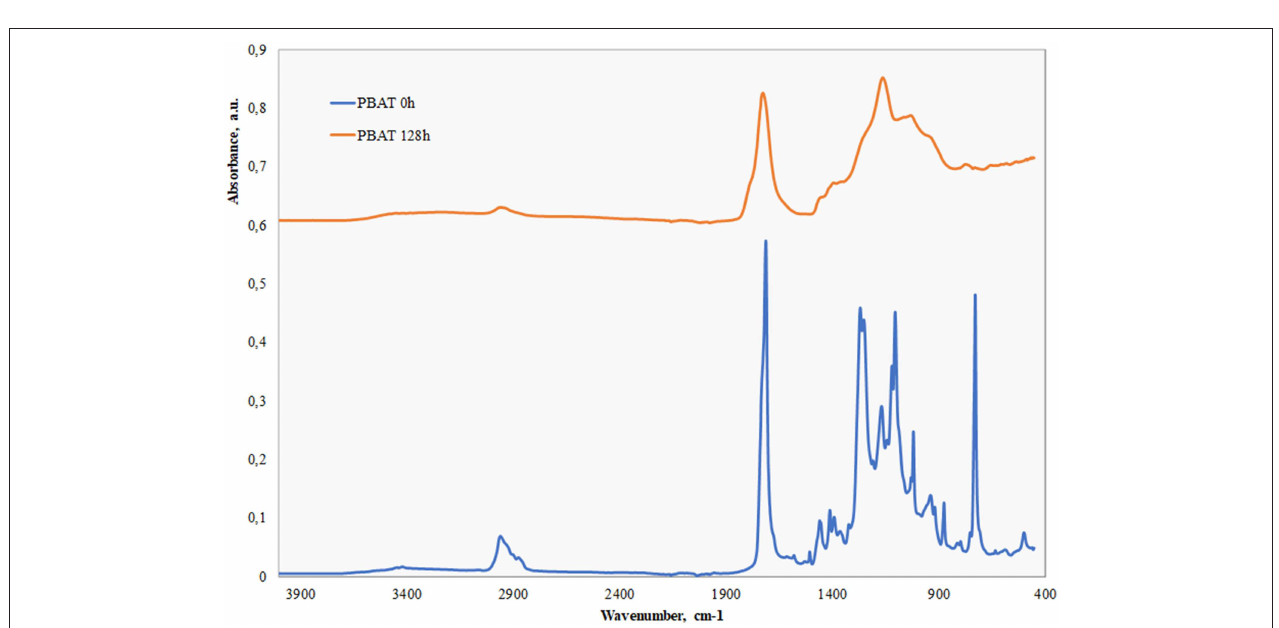
FIGURE 3 | ATR spectra of pristine and photooxidized